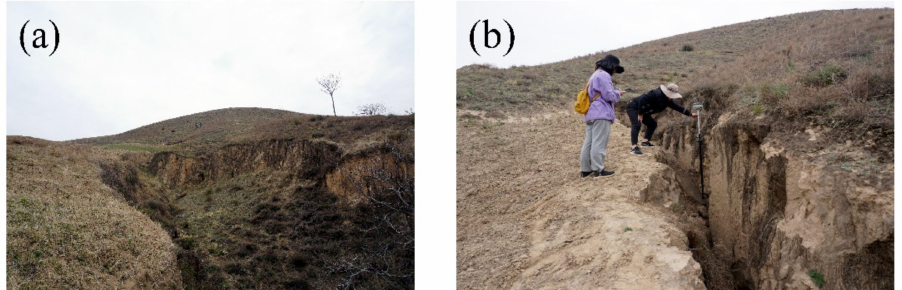
Figure 3. Field photographs of the gully in the study area. ( a ) Photo of a typical gully. ( b ) Photo of a measured